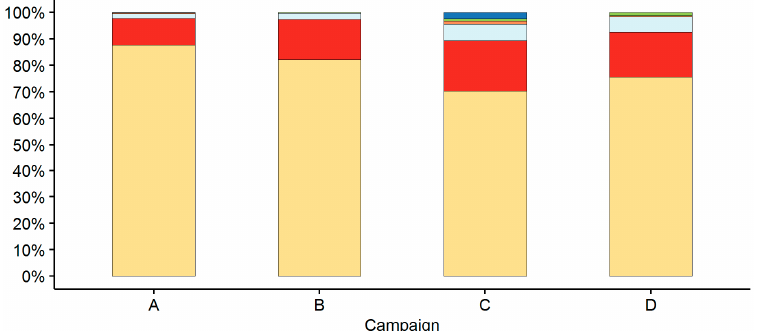
Figure 4. Share of productive time (PSH 0 ) ( beige ) and the various delay times: IT (interference time) ( red ); PT (preparatory times) ( light blue ); MT (maintenance times) ( orange ); RP (rest and personal times) ( green ); and RT (repair times) ( navy ), as measured during the actual operation times (SSH Operation ), excluding pre-operational work process such as rigging and excluding official break and meal times.